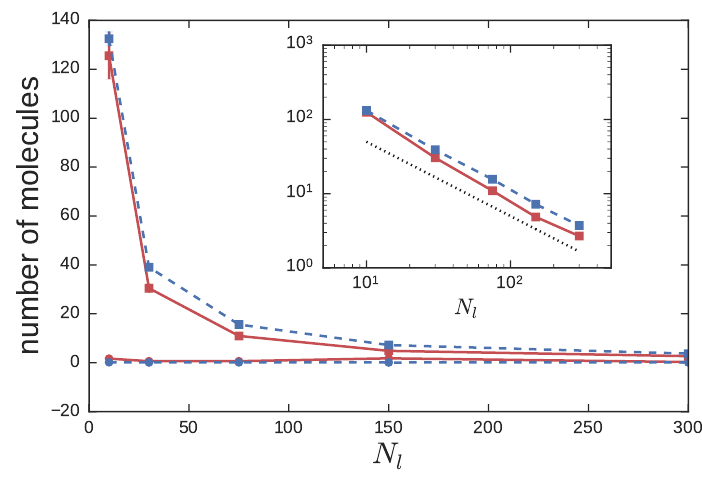
Figure 6. The number of polymers—RPs (circles) and LPs (squares)—contained within one radius of gyration of a probe RP in the asymmetric blend simulations. Red solid lines represent NC simulations, while blue dashed lines represent CX simulations. The inset replots the LP data on a log-log scale. . The dotted line is proportional to N − 1 l